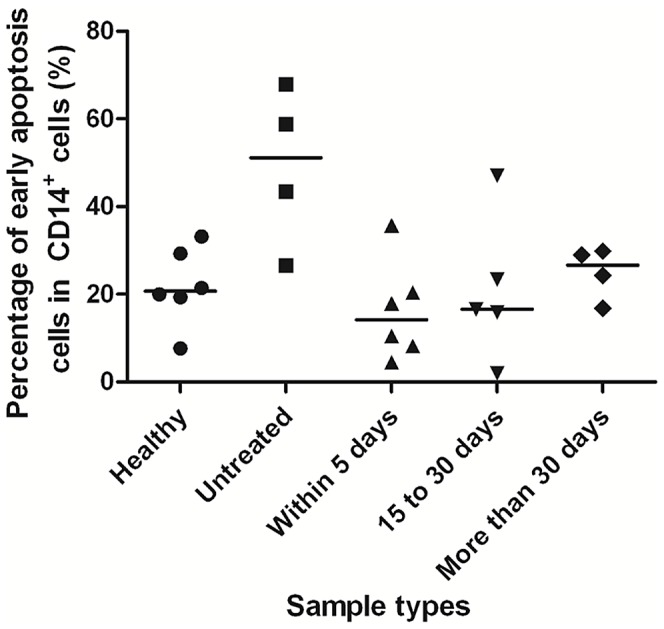
Percentage of early-apoptosis CD14+ cells from healthy donors or the continuously treated PTB patients.Apoptotic CD14+ cells were analyzed by flow cytometry using Annexin V plus PI staining in vitro. Annexin V+PI− cells represent the early apoptotic populations. Healthy, healthy donors; untreated, untreated PTB patients; within 5 days, PTB patients who received regular anti-TB treatment within 5 days; 15 to 30 days, PTB patients received regular treatment for 15–30 days; More than 30 days: PTB patients received regular treatment for >30 days. The presented data indicate that the percentage of apoptotic cells dramatically decreased after treatment.